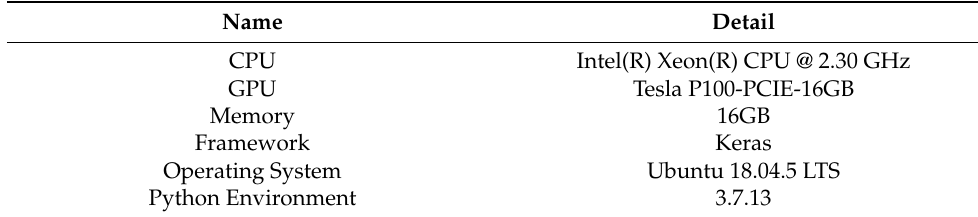
Table 3. Configuration for training the DFTrans model.